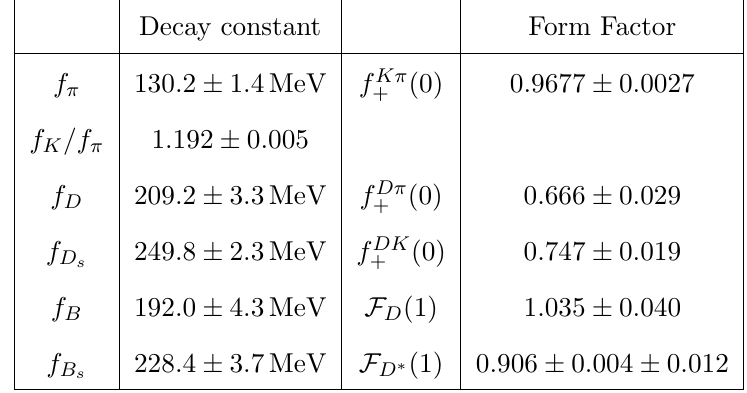
Table 8 . Lattice input on pseudoscalar meson decay constants and form factors. We use the FLAG lattice averages with n f = 2 + 1